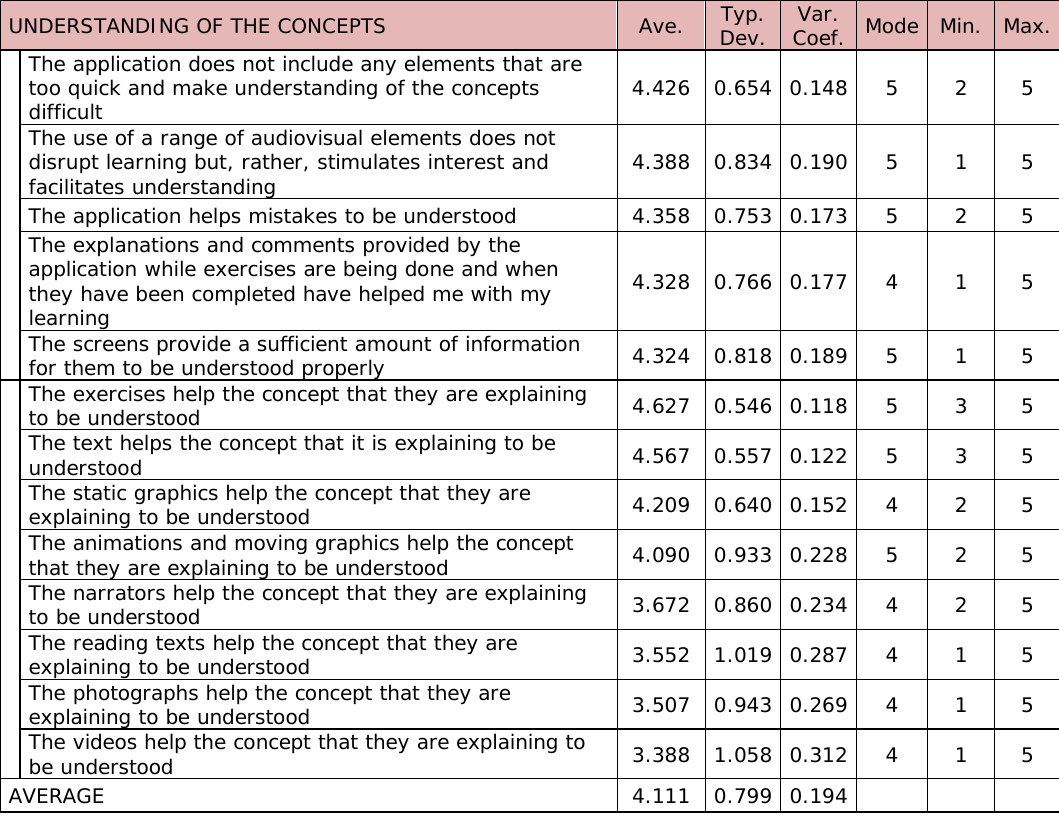
Table 7. “Assessment of Understanding of